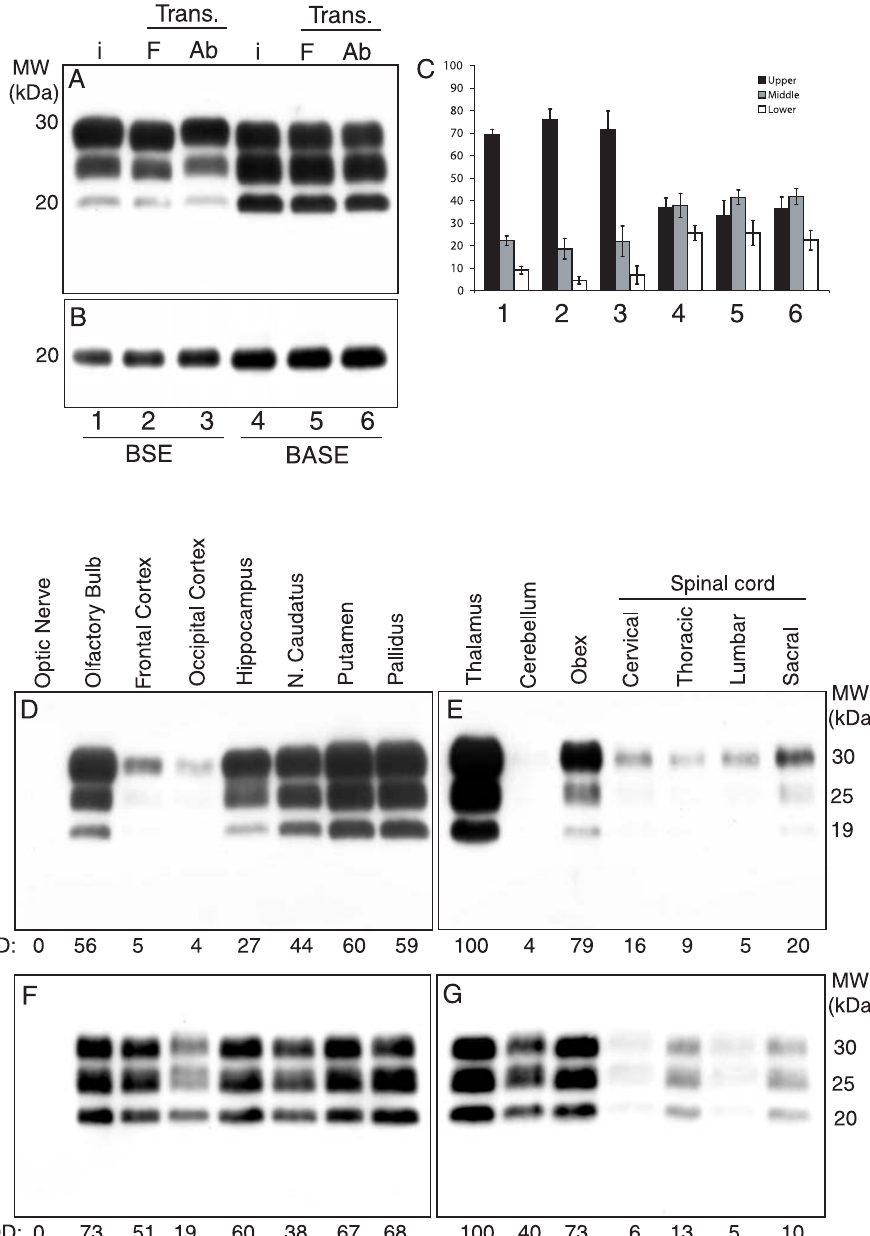
Figure 2. Biochemical analysis and regional distribution of PrP TSE in BSE and BASE experimentally infected cattle. (A) Immunoblot with 6H4 of proteinase K-treated brain homogenates from BSE and BASE inocula (abbreviated as i) (lanes 1 and 4) from Friesian (abbreviated as F) and Alpine brown (abbreviated as Ab) inoculated with BSE (lanes 2 and 3, respectively), and BASE (5 and 6, respectively); (B) samples after PNGase F- treatment. (C) Relative proportions of the three PrP TSE glycoforms in BSE and BASE inocula and in infected cattle. (Standard error bars correspond to variations of PrP TSE glycoform in the inocula, as determined in six replicates. On the contrary, in Friesians and in Alpine browns cattle inoculated with BSE and BASE determination was performed on at least six different brain areas from each animal) (D–G) Brain regional distribution of PrP TSE in BSE (D and E) and BASE (F and G) infected cattle. Values below each lane correspond to the relative percentage of PrP TSE normalized against thalamus. MW, molecular weights; kDa: kilodaltons; OD: optical density.